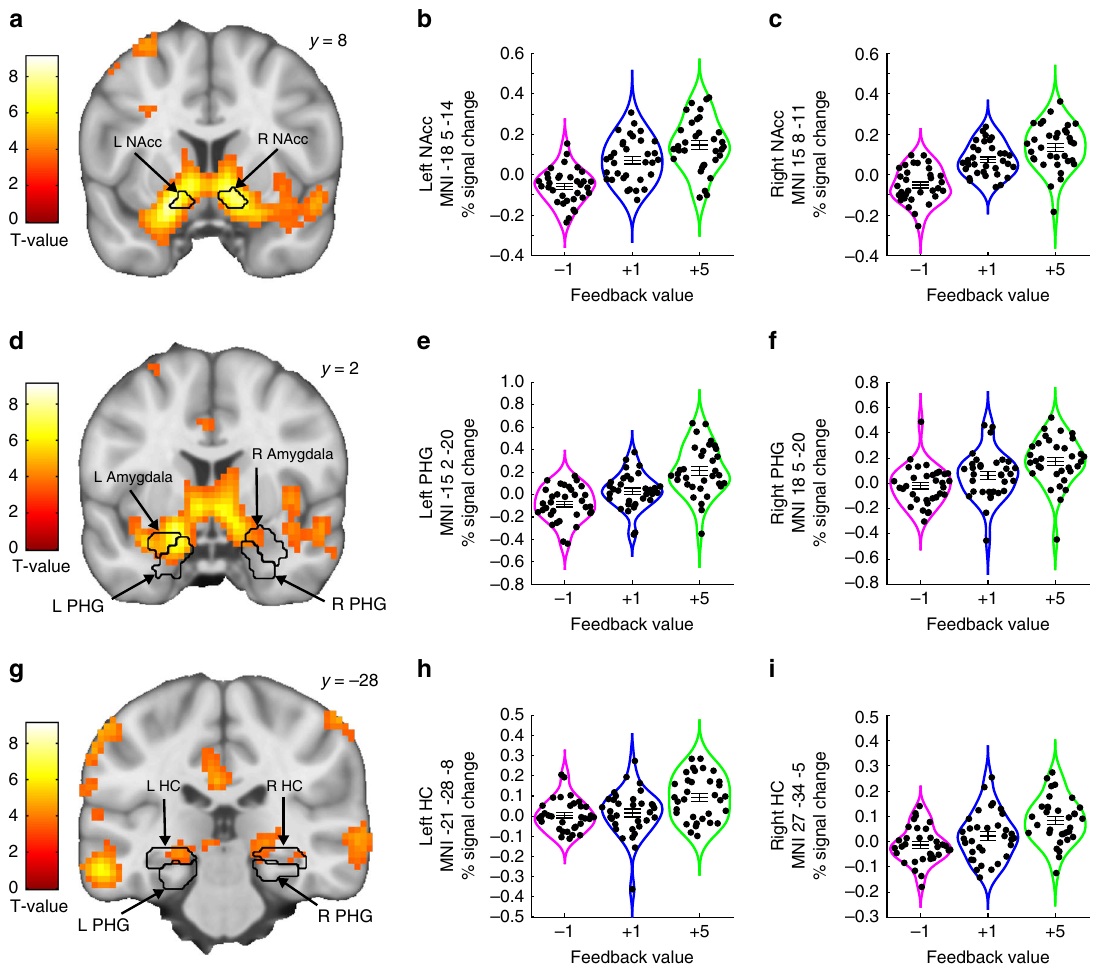
Fig. 3 Linear BOLD signal increases as a function of feedback value. BOLD signal in the bilateral NAcc ROI ( a – c ), and the HC/PHG ROIs ( d – i ) increased monotonically with feedback value. For display purposes, the violin plots show the average % signal change extracted from 3-mm spheres centered on peak voxel coordinates for each signi fi cant activation cluster. The horizontal lines indicate mean ± SEM. The BOLD signal is shown using an uncorrected threshold of p < 0.001. NAcc nucleus accumbens ROI, HC hippocampus ROI, PHG parahippocampal gyrus ROI, Amygdala amygdala ROI. Source data are provided as a Source Data fi le. T statistics were obtained from t- T(32) = 3.751; pSVC = 0.037). Moreover, dACC BOLD signal signi fi cantly and linearly correlated with average reward levels (Fig. 5d, e; peak MNI x y z = 0 32 22; T(32) = 4.155; pSVC = 0.016).